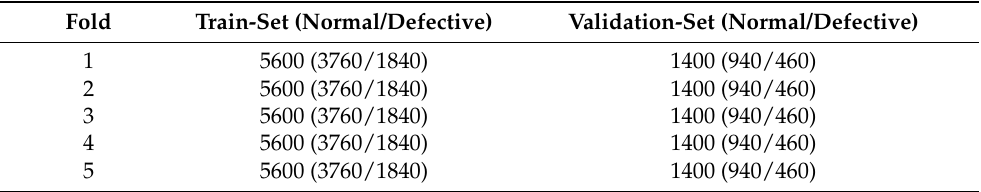
Table 3. Data splitting according to five-fold Stratified K-Fold cross-validation on imbalanced dataset. Fold Train-Set (Normal/Defective) Validation-Set (Normal/Defective) 5600